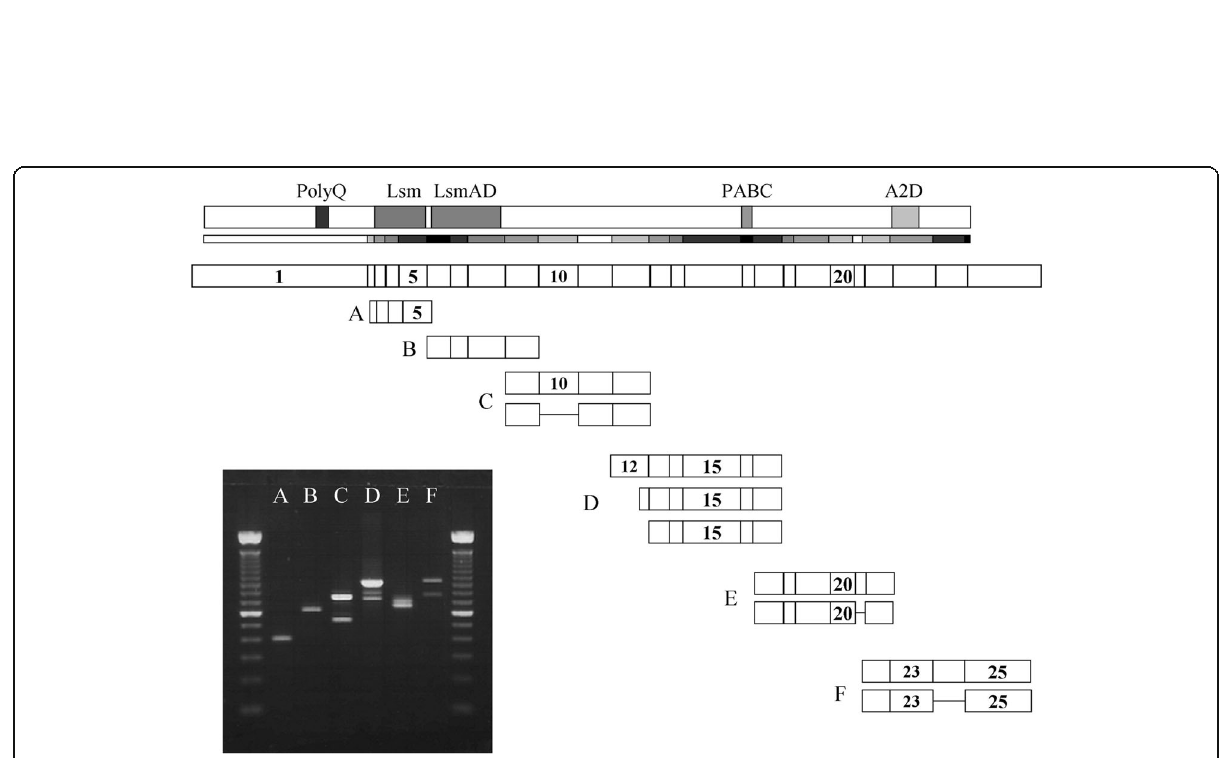
Fig. 2 Above: Comparison of the structure of ataxin-2 at different levels. The first scheme presents ataxin-2 protein domains (A2D is an additional domain that is in common between ataxin-2 and ataxin-2-like, as reported by Meunier-C et al. 2002 J Biol Chem). The second scheme presents the exons that code for the protein. The third scheme presents the exon structure of ataxin-2. Below: For lanes a – f of the gel picture, each PCR band was sequenced and the shorter bands were shown to be deficient in different exons. Amplification fragments represent exons: A: 2 – 5 B: 6 – 9; C: 9 – 12; D: 12 – 17; E: 17 – 22; F: 22 – 25. RT-PCRs from HeLa RNA were resolved on a 2% agarose-gel, showing the different splice variants. The schematic PCR fragments to the right represent the sequencing results for full length PCR fragments and the shortened variants lacking different exons or exon